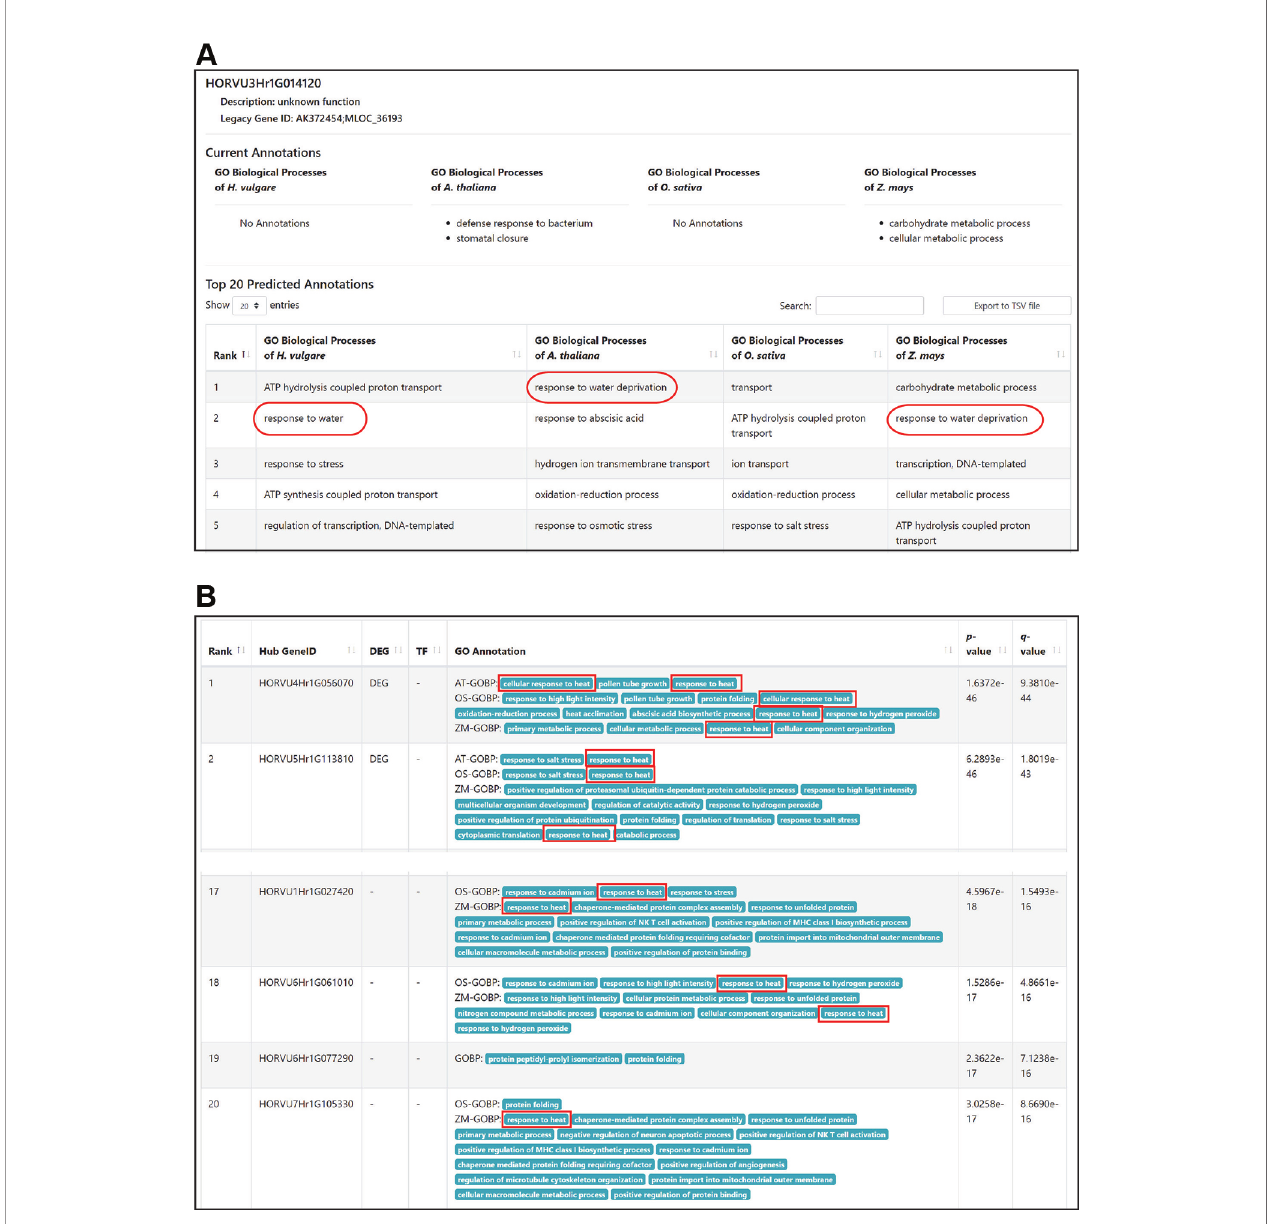
FIGURE 4 | Example results from gene-centric search and context-centric search analyses using BarleyNet. (A) Screenshot of BarleyNet gene-centric search results with gene HORVU3Hr1G014120, which was not annotated by barley GOBP terms. GOBP terms for drought response, “ response to water ” and “ response to water deprivation, ” are marked by red circles. (B) Screenshots of BarleyNet context-centric search results with 625 upregulated differentially expressed genes upon heat stress in the roots of barley cultivar Rolap. The predicted genes between rank 2 and 16 were omitted. GOBP terms for heat stress response are marked by red